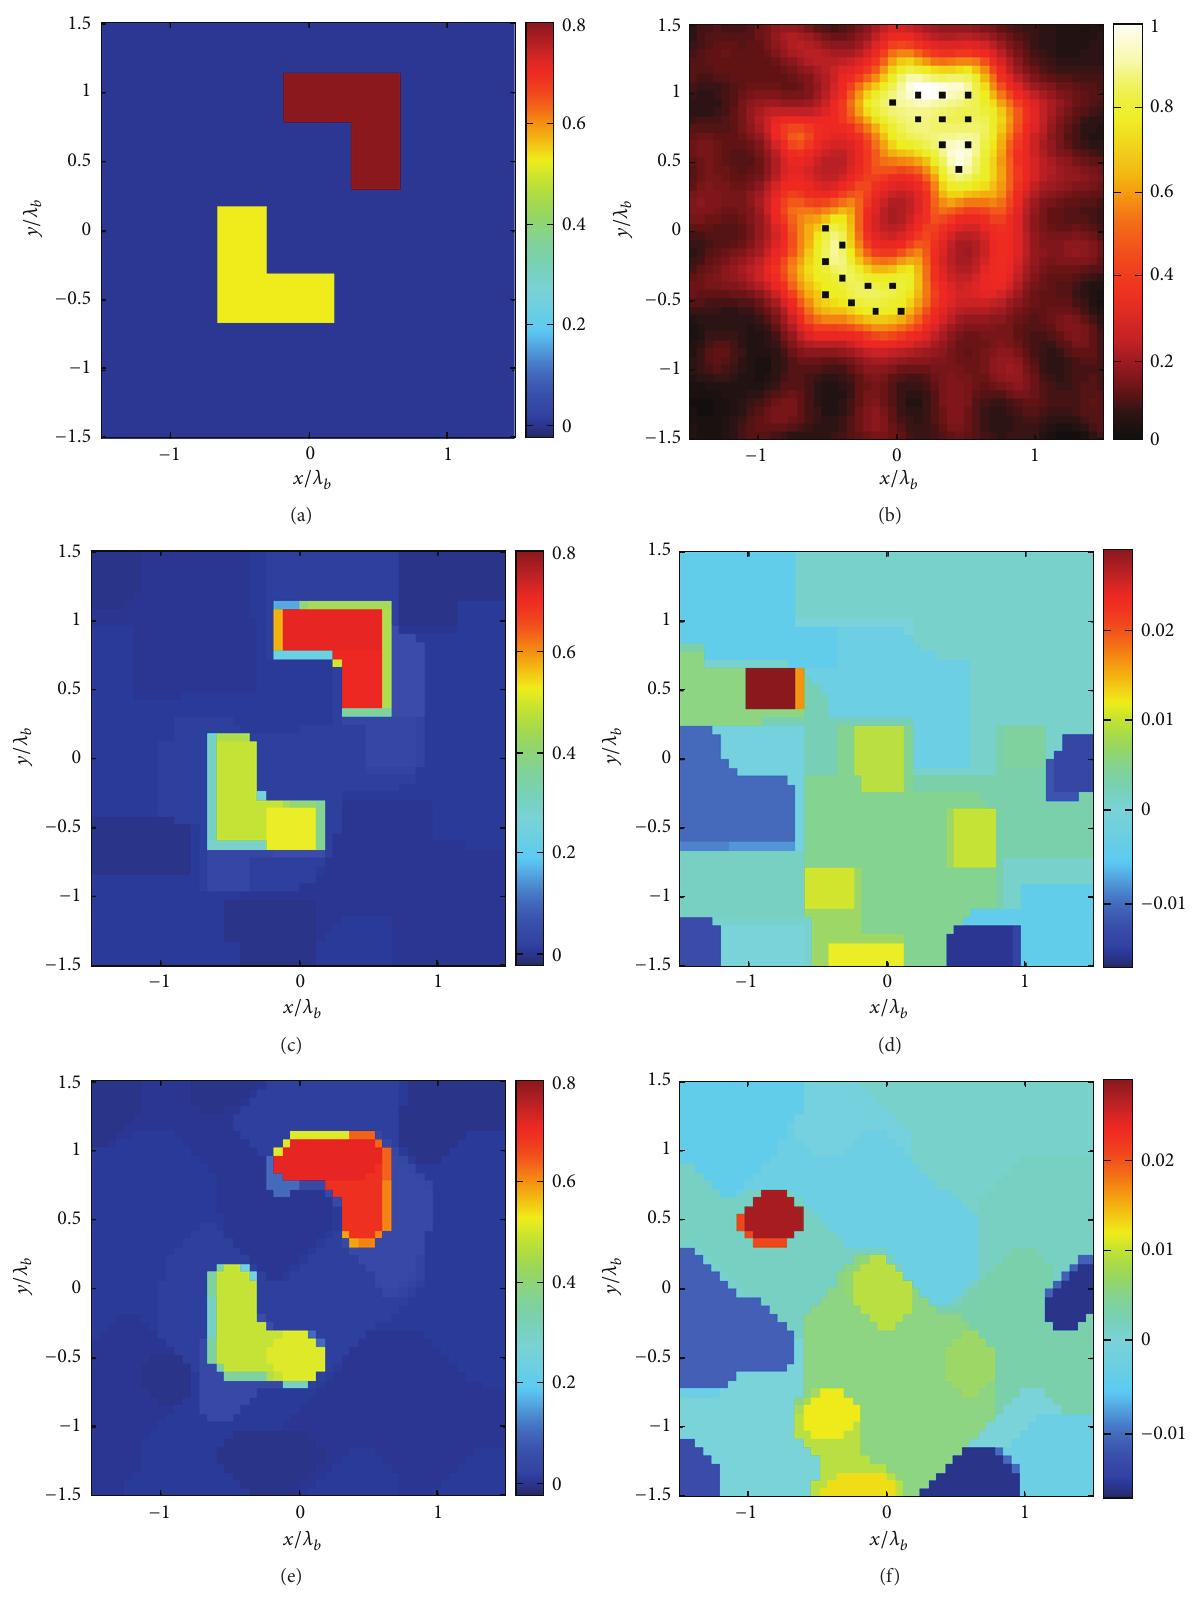
Figure 2: The double L scattering system. (a) Real part of the contrast reference profile. (b) Normalized logarithmic LSM indicator with the selected pivot points superimposed as dots. The retrieved profile by means of the approach (4) ( 𝛿 = 0.2‖ b ‖ ℓ imaginary part. The retrieved profile by means of the approach (5) ( 𝛿 = 0.2‖ b ‖ ℓ